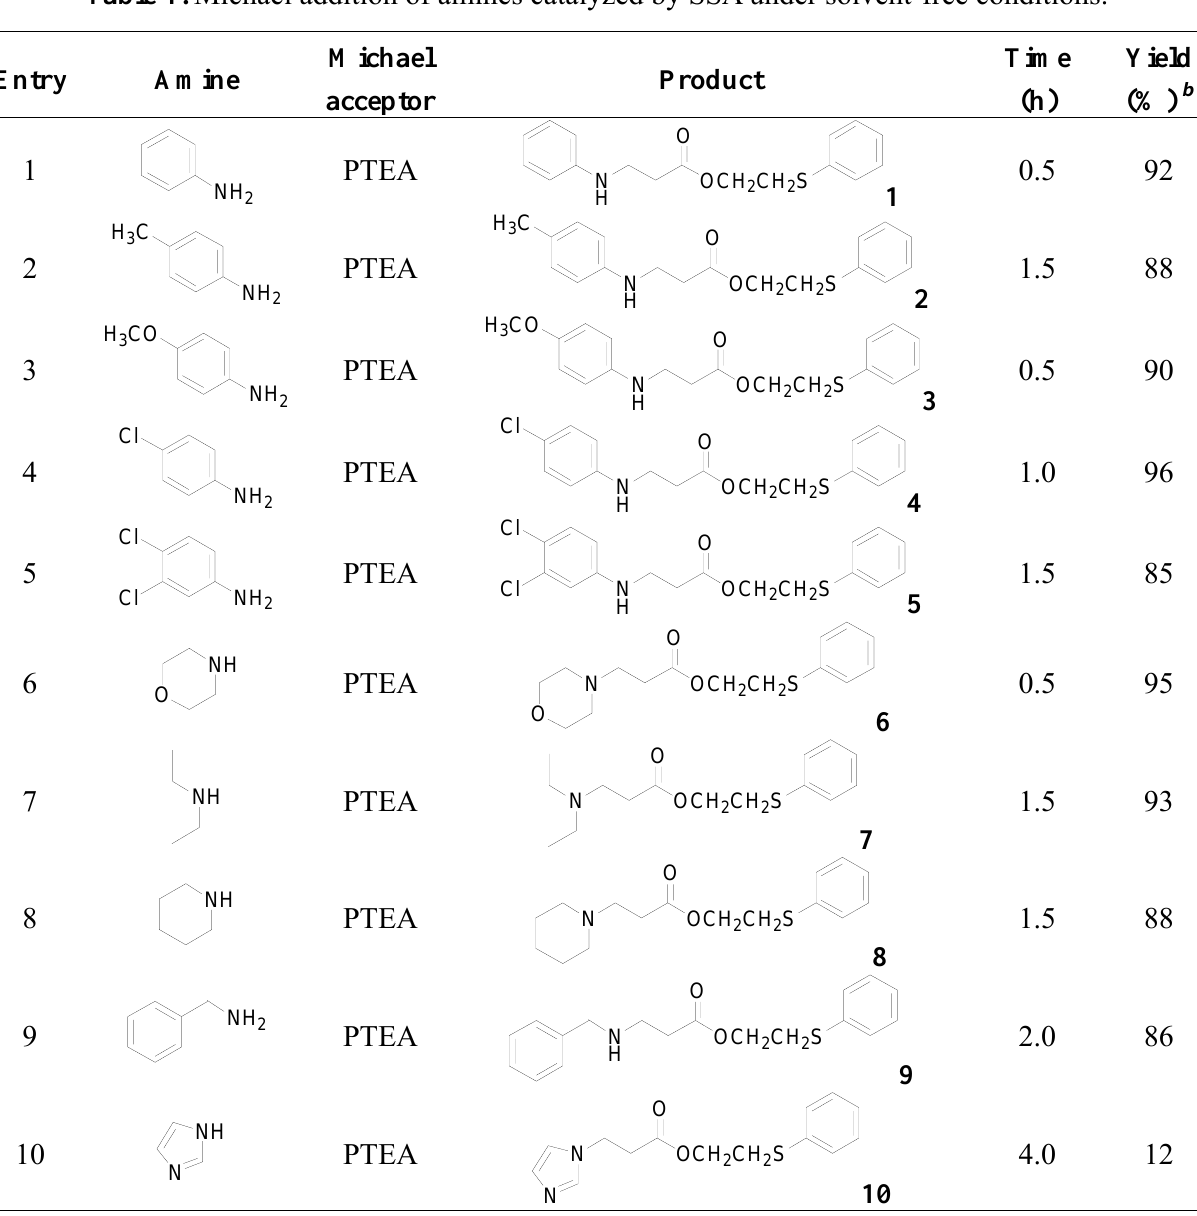
Table 1. Michael addition of amines catalyzed by SSA under solvent-free